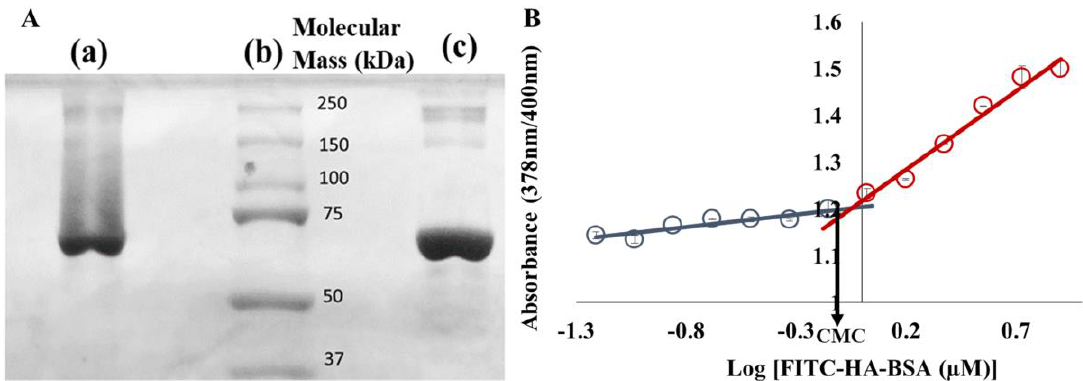
Figure 1. ( A ) Sodium dodecyl sulfate polyacrylamide gel electrophoresis (SDS-PAGE) of: ( a ) a solution of fluorescein isothiocyanate-hyaluronic acid-bovine serum albumin (FITC-HA-BSA) conjugates, ( b ) standard MW markers, and ( c ) BSA; ( B ) Relative 1,6-diphenyl-1,3,5-hexatriene (DPH) absorbance at 378 nm and 400 nm vs. increasing concentrations of FITC-HA-BSA. The final concentration of DPH was 1%. The critical micellization concentration (CMC) (1.1 µM) was determined as the intersection point of the two extrapolated lines.